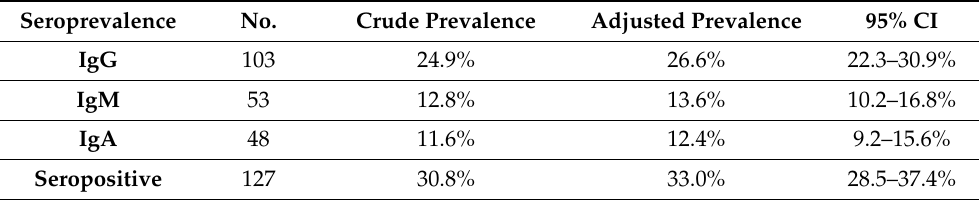
Table 2. Crude and adjusted seroprevalence values of COVID-19 antibodies among children in Aseer region, Saudi Arabia.